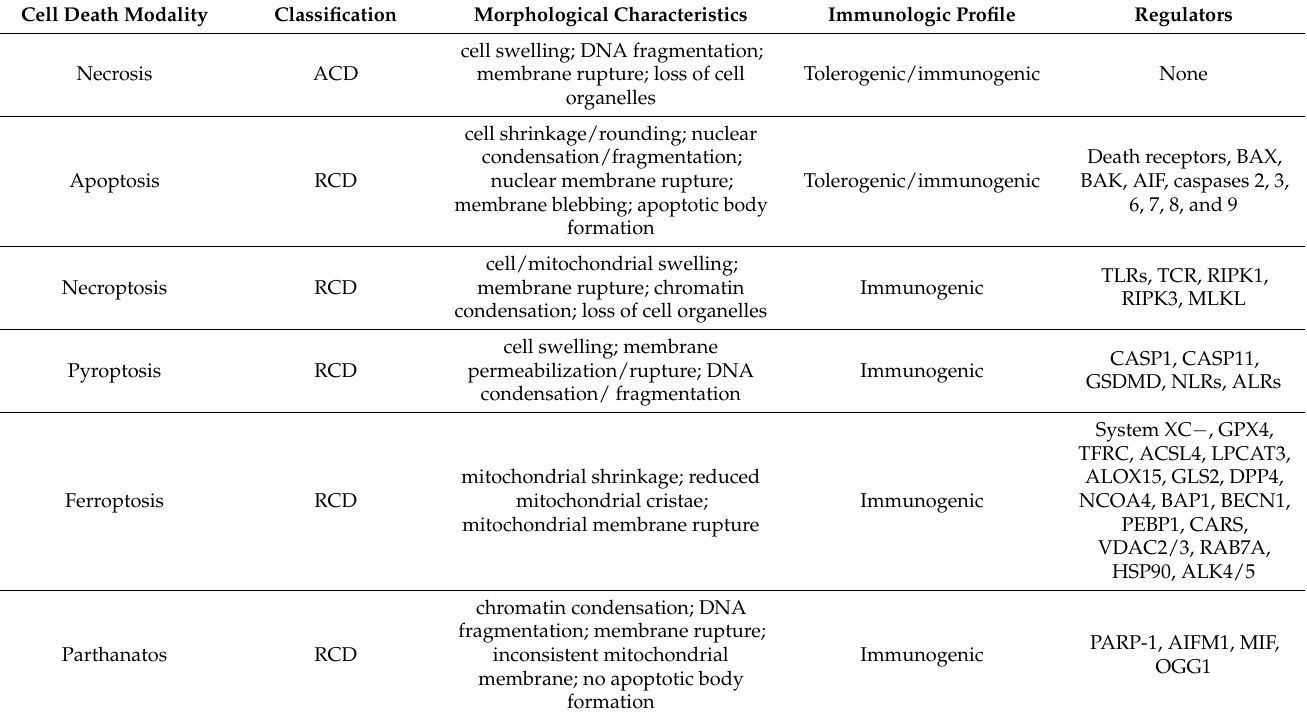
Table 1. The classification and characteristics of various cell death modalities. Important regulators mediating each death type are listed in the last